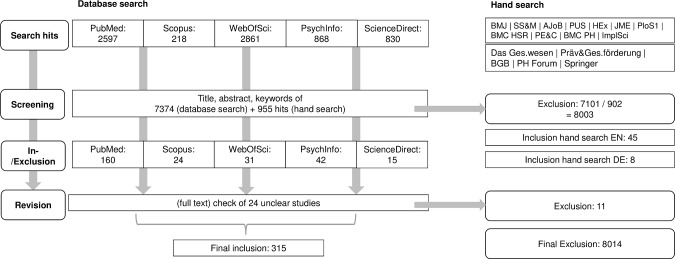
Database search.